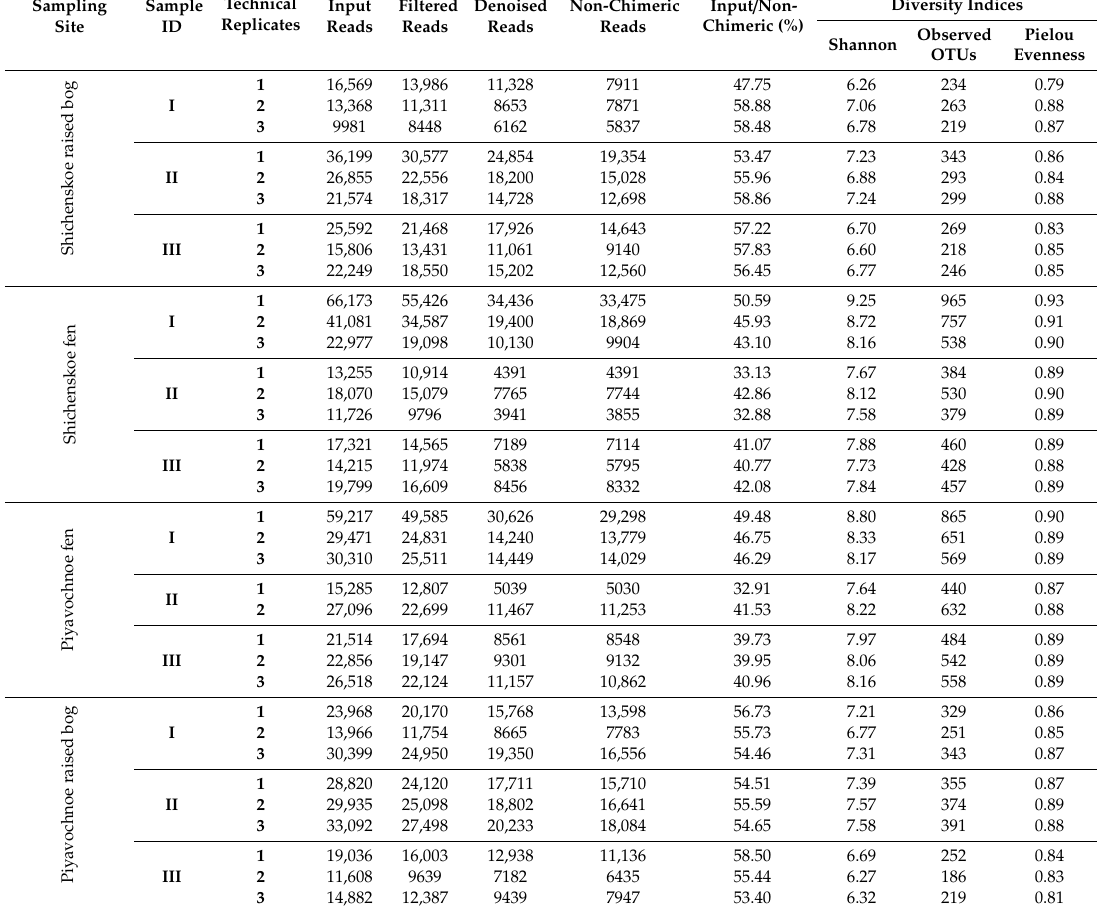
Table 2. Sequencing statistics and alpha-diversity